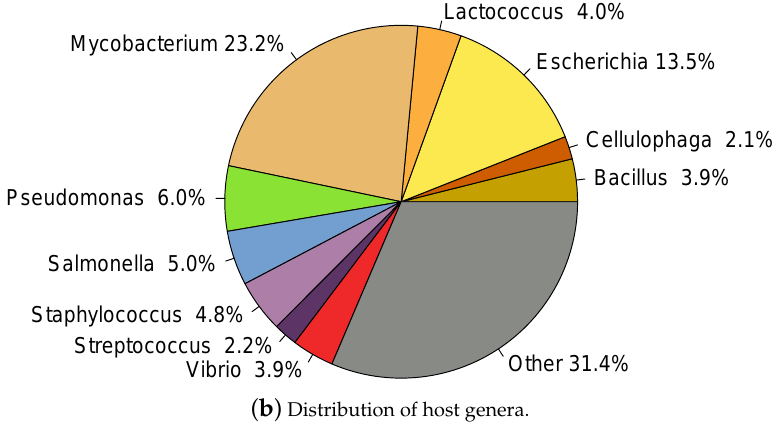
Figure 1. Hosts represented in the database. Species ( a ) and genera ( b ) representations are displayed in the same genera-colour